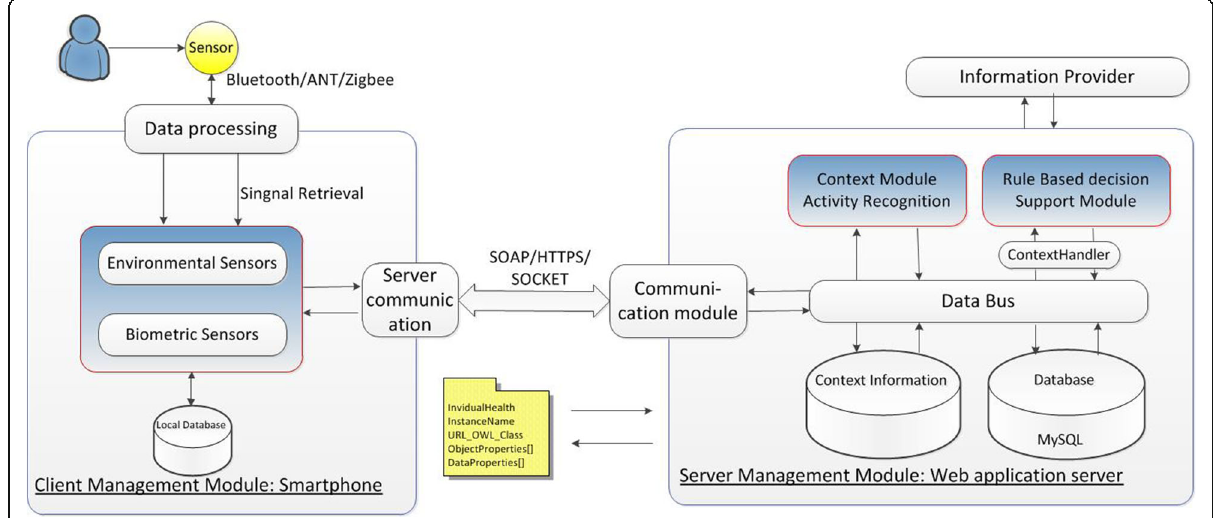
Fig. 2 Structure design of IoT based medical remote monitoring system